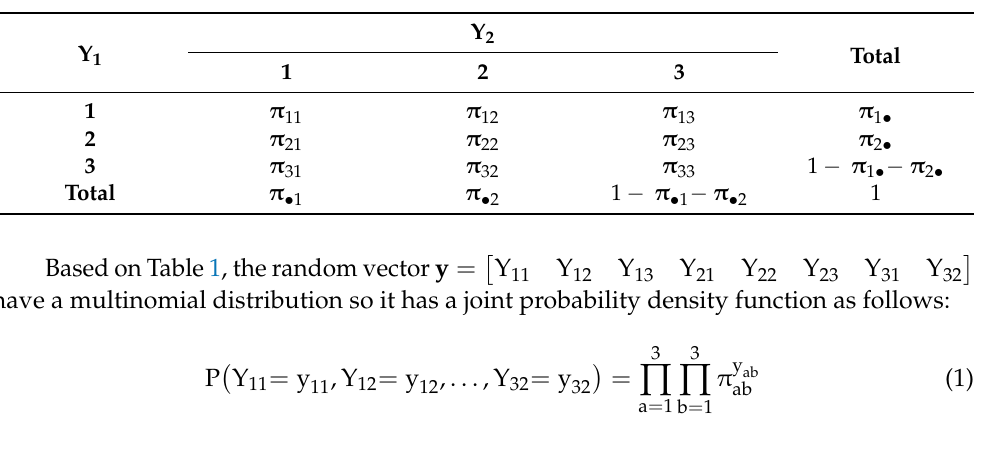
Table 1. Probabilty of the response